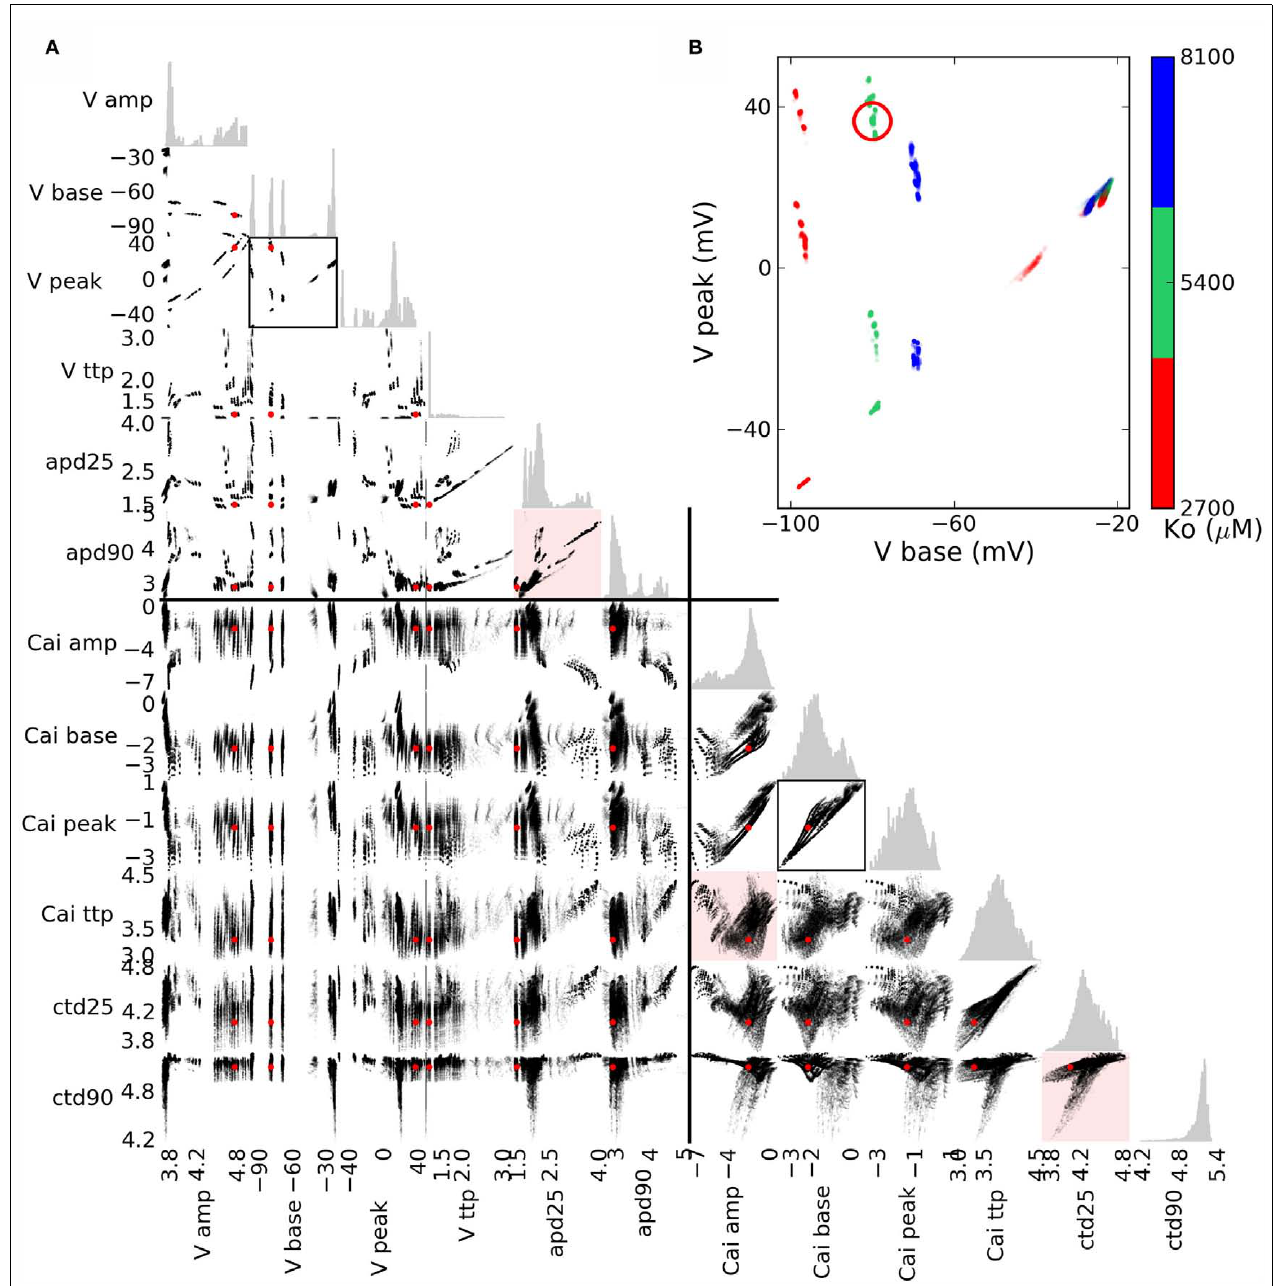
shape, whereas ctd90 vs. ctd25 shows more gradual variability, though the relation between amplitude and time to peak is complex. (B) Clustering of AP base and peak phenotypes exemplifies that they are affected by only a couple of simulated genes, one of which is Ko, determining the extracellular potassium